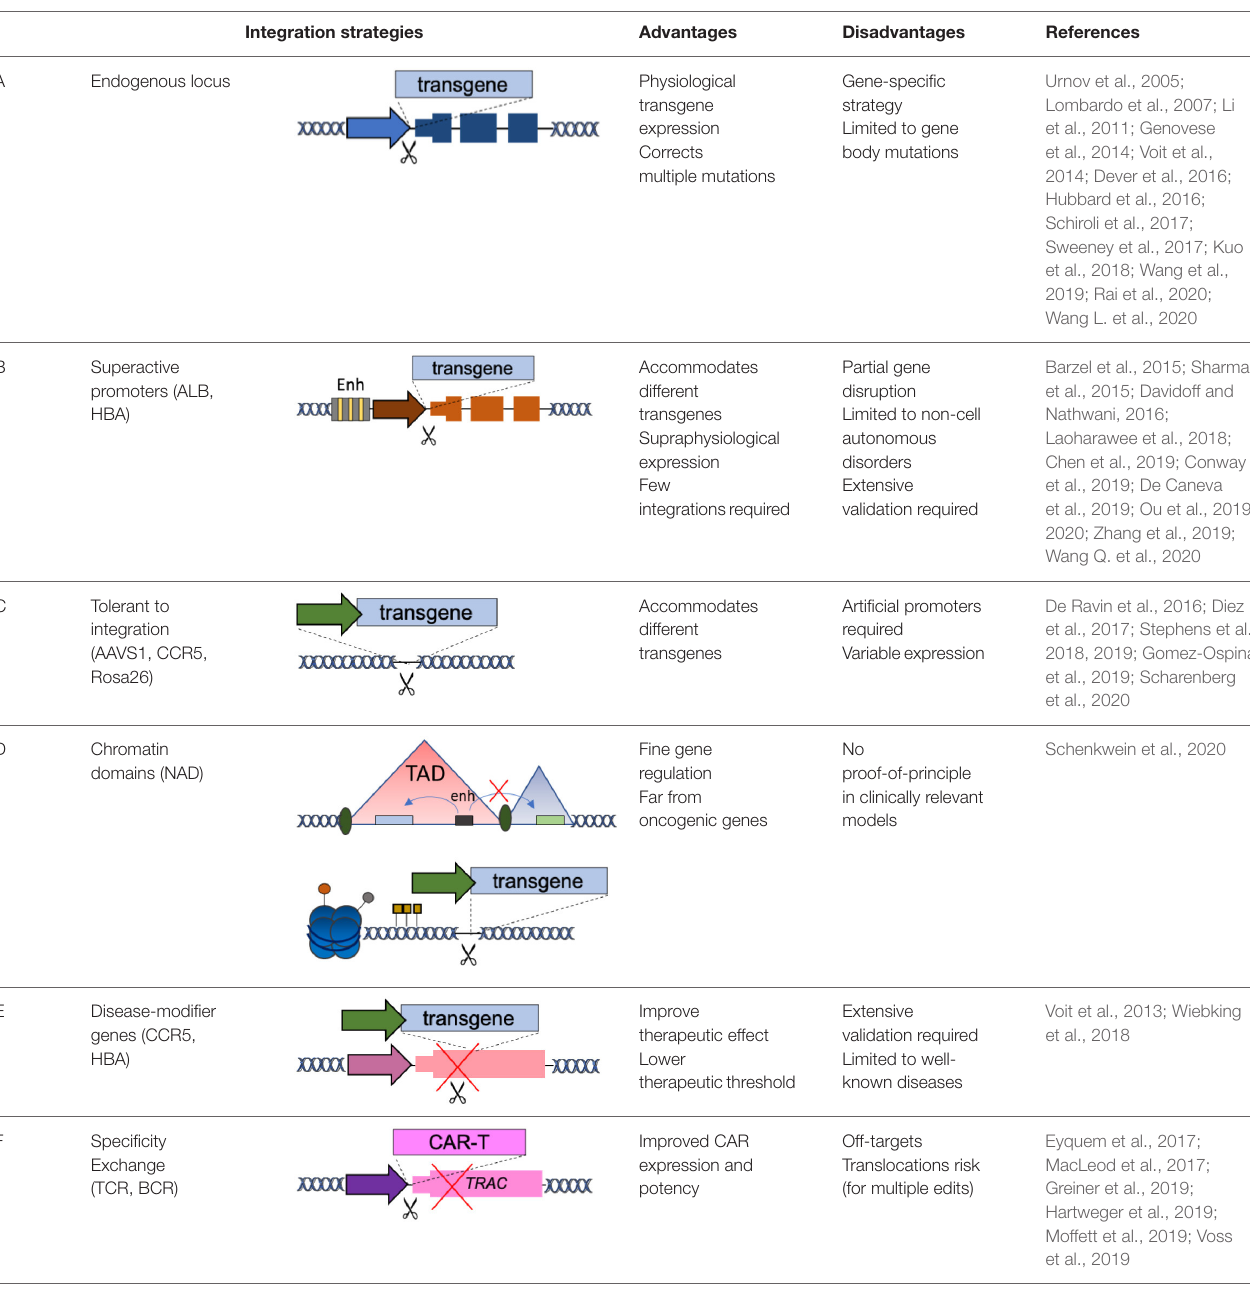
TABLE 1 | (A–F) The advantages and disadvantages of different integration